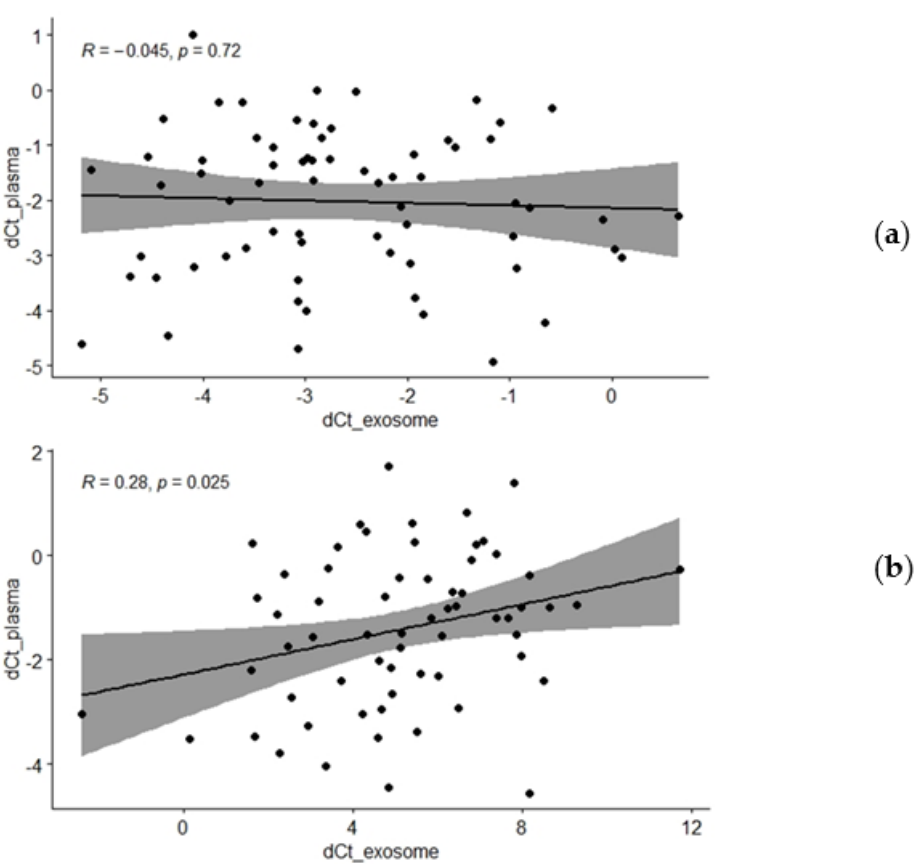
Figure 3. Correlation of miR-375 and miR-21 ( a , b , respectively) expression levels between whole plasma and plasma-derived exosomes of all participants (joint PCa and BPH groups). Relative expression of each microRNA was normalized against the spike-in and endogenous controls in plasma and exosome samples (dCt_plasma, y -axis; dCt_exosomes, x -axis). Pearson correlation coefficients (R) and the matching p values corresponding to the linear regression analysis are shown on scatter plots. dCt—delta cycle threshold.